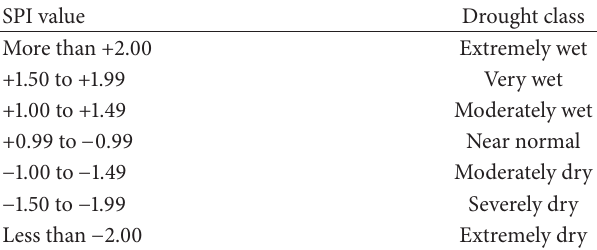
Table 4: A classification of the SPI that classifies the SPI into extreme, severe, and moderate classes for both wet and dry moisture